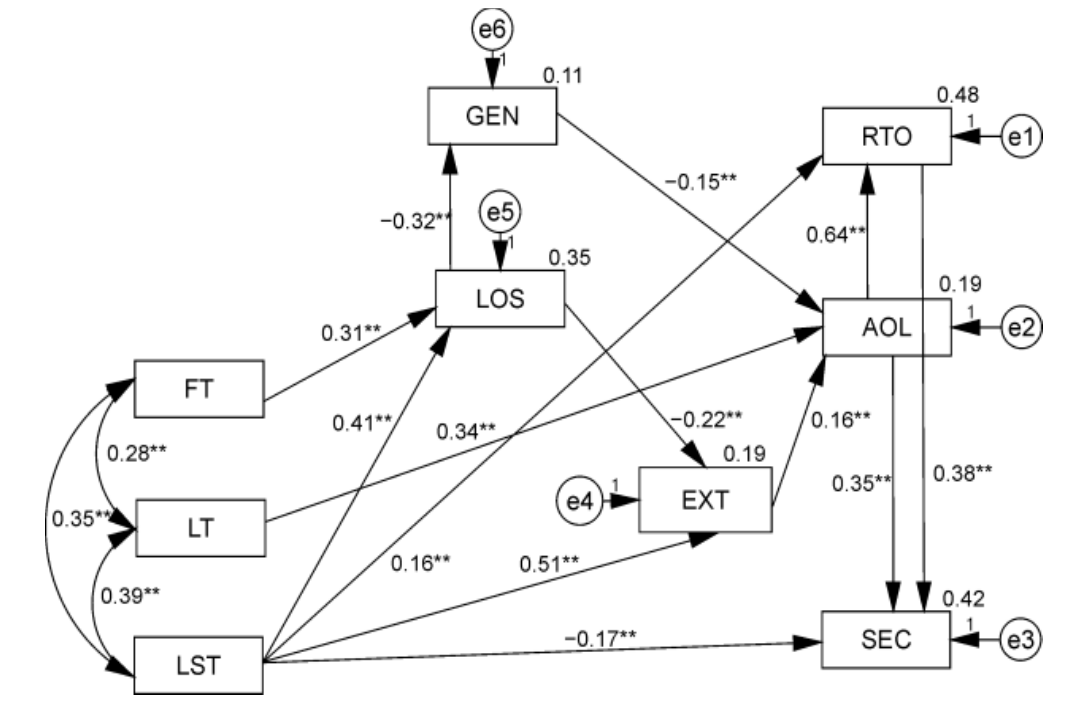
Figure 1. Results from structural equation modelling for the effects of pandemic threats (FT, LT, and LST) on dimensions of post-traumatic growth (changes in RTO, AOL, and SEC), with mediating effects of EXT, LOS, and GEN (standardised coefficients). Note : All parameters are significant at the p < 0.01 level **.